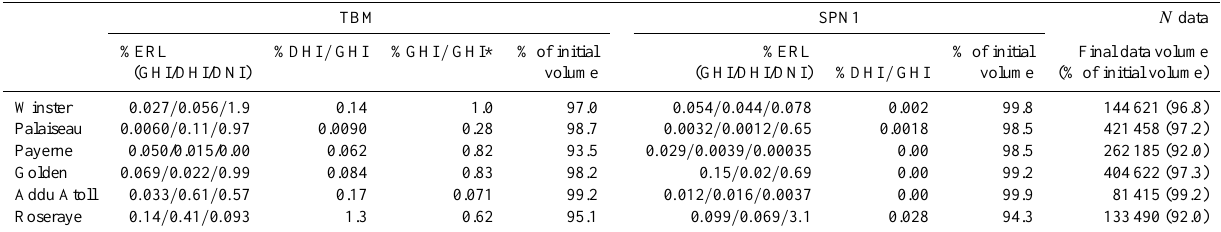
Table 3. Data percentage (with respect to the initial data volume for SZA < 80 ◦ ) of data not passing BSRN quality control recommended tests v2 for GHI, DHI and DNI measurements – ERL, diffuse ratio test (DHI / GHI) and the ratio of GHI to calculated global from DHI and DNI (GHI / GHI*). The percentages of data passing the tests for SZA < 80 are separately given for TBM and SPN1 and the total volume of